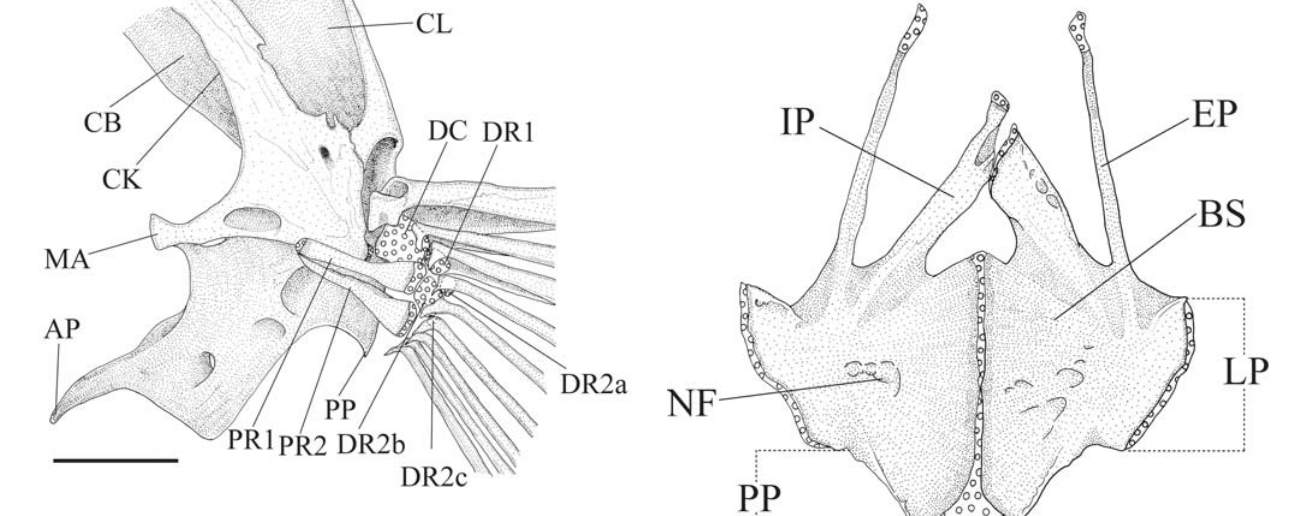
PR1-2 ) proximal radials 1 and 2. Scale bar = 0.7 mm.